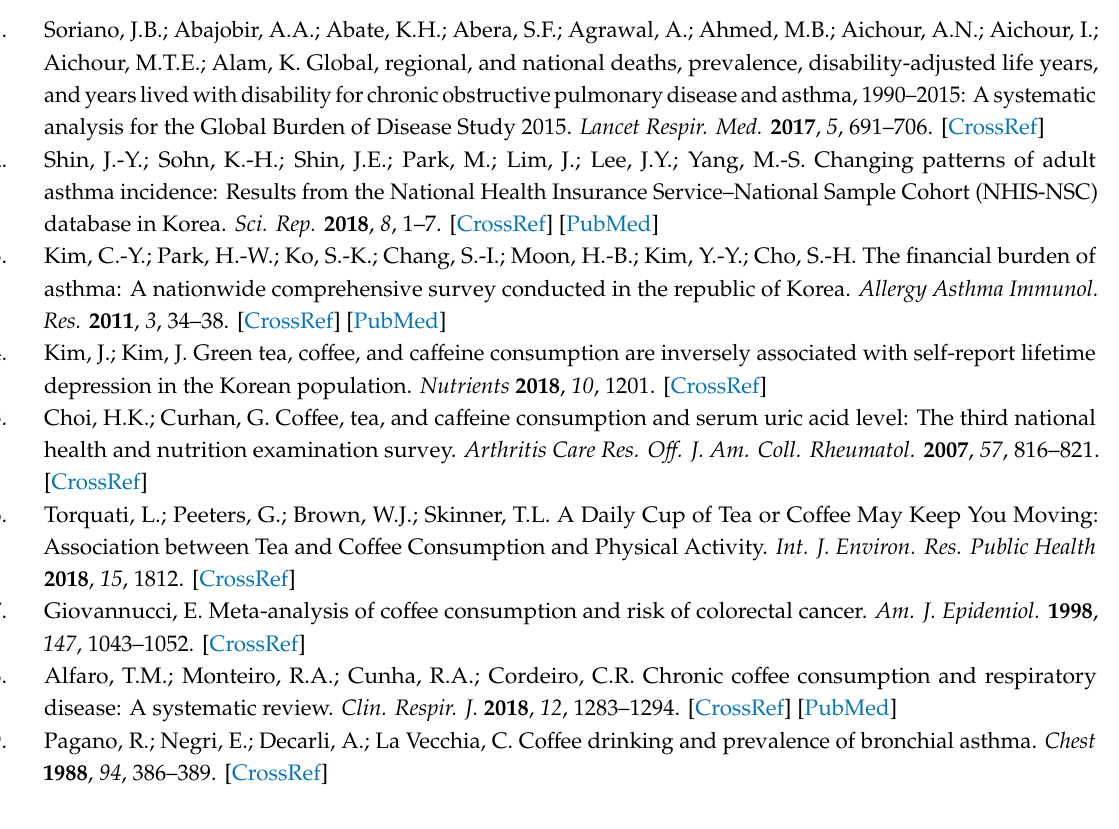
Table S1: Crude and adjusted odds ratios (95% confidence interval) for asthma by co ff ee intake (frequency) according to age, sex, and smoking status, Table S2: Crude and adjusted odds ratios (95% confidence interval) for asthma by co ff ee intake (amount) according to age, sex, and smoking status, Table S3: Crude and adjusted odds ratios (95% confidence interval) for asthma by green tea intake (frequency) according to age, sex, and smoking status, Table S4: Crude and adjusted odds ratios (95% confidence interval) for asthma by green tea intake (amount) according to age, sex, and smoking status, Table S5: Crude and adjusted odds ratios (95% confidence interval) for asthma by soda drink intake (frequency) according to age, sex, and smoking status, Table S6: Crude and adjusted odds ratios (95% confidence interval) for asthma by soda drink intake (amount) according to age, sex, and smoking status, Table S7: Frequency of co ff ee / green tea / soda drink intake according to sex, Table S8: Incidence of developed asthma during the follow-up period according to the frequency and amount of co ff ee / green tea / soda drink intake, Table S9: Adjusted odds ratios (95% confidence interval) for asthma by co ff ee, green tea, and soda drink